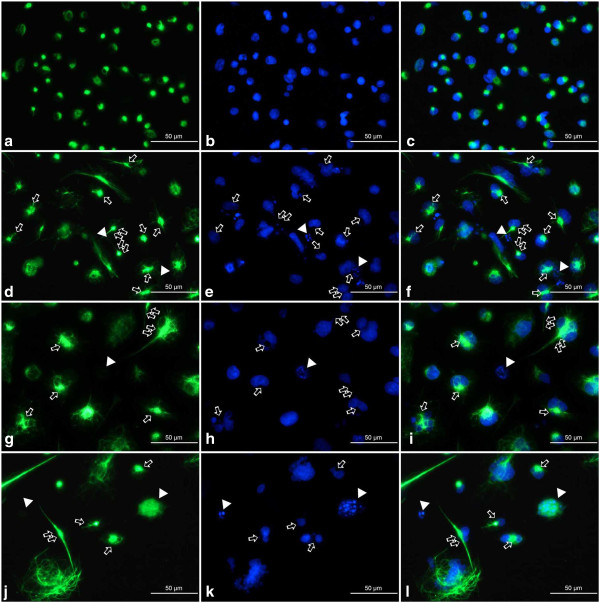
a-l Organization of vimentin in A549 cells after treatment with etoposide - fluorescence microscopic examination (vimentin indirect labeling, secondary antibody was goat anti-mouse IgG-BODIPY). a-c Control cells, d-f 0.75 μM etoposide, g-i 1.5 μM etoposide, j-l 3 μM etoposide; a, d, g, j vimentin labeling, b, e, h, k DAPI, c, f, i, l merged. Staining with this method allow us to visualize in a great detail subtle threads of vimentin filaments located in the invaginations of nuclei. Apart from regularly organized bundles of filaments in the control cells, abundant, but more heterogeneously organized structures appeared as a result of the treatment. Thick arrows point at thin threads in the nuclear invaginations or more dense vimentin bundles in the form of septum-like aggregates between sister nuclei, especially common in multinucleated cells; double thick arrows - cells presenting long vimentin tails (vimentin staining), closely located sister nuclei or thin chromatin threads connecting closely located sister nuclei (DAPI); arrowheads - diffuse vimentin staining around nuclei with features of karyorrhexis or karyolysis. Results are indicative of five independent experiments. Bar 50 μm.